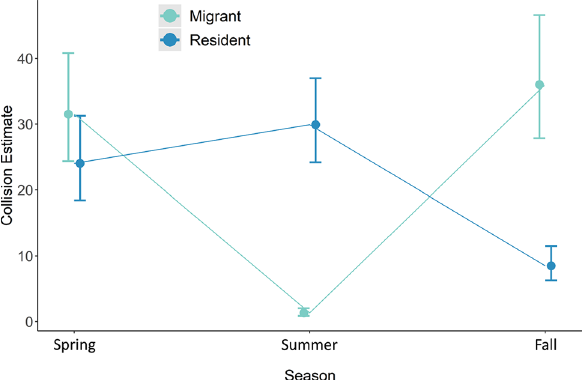
Figure 3. Interacting effect of season and residency status on variation in bird-window collisions. Interaction plot illustrating model-predicted numbers (± standard errors) of collisions for different combinations of residency status (i.e., whether individual birds that collided were migrants or residents) and season (spring, summer, fall). This interaction was the only predictor variable in the only confidence set model (i.e., ΔAICc ≤ 2) in an analysis of factors associated with raw counts of total fatal bird collisions (including feather piles) in Stillwater, Oklahoma, USA in 2015–2016 (model selection results in Table